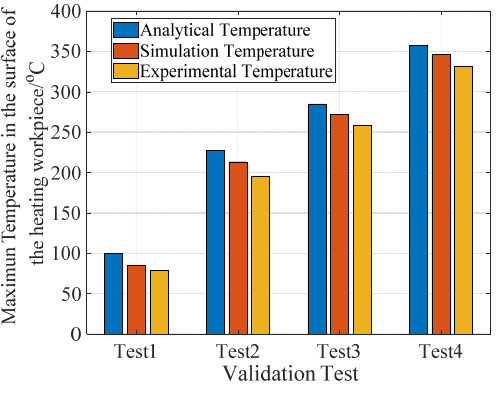
Appl. Sci. 2018 , 8 , x FOR PEER REVIEW 11 of 13 Figure 15. Maximum temperature validation in the surface of the workpiece ( v = 5 mm/s). Figure 15. Maximum temperature validation in the surface of the workpiece ( v = 5 mm/s). Figure 15. Maximum temperature validation in the surface of the workpiece ( v = 5 mm/s). Figure 15. Maximum temperature validation in the surface of the workpiece ( v = 5 mm/s).